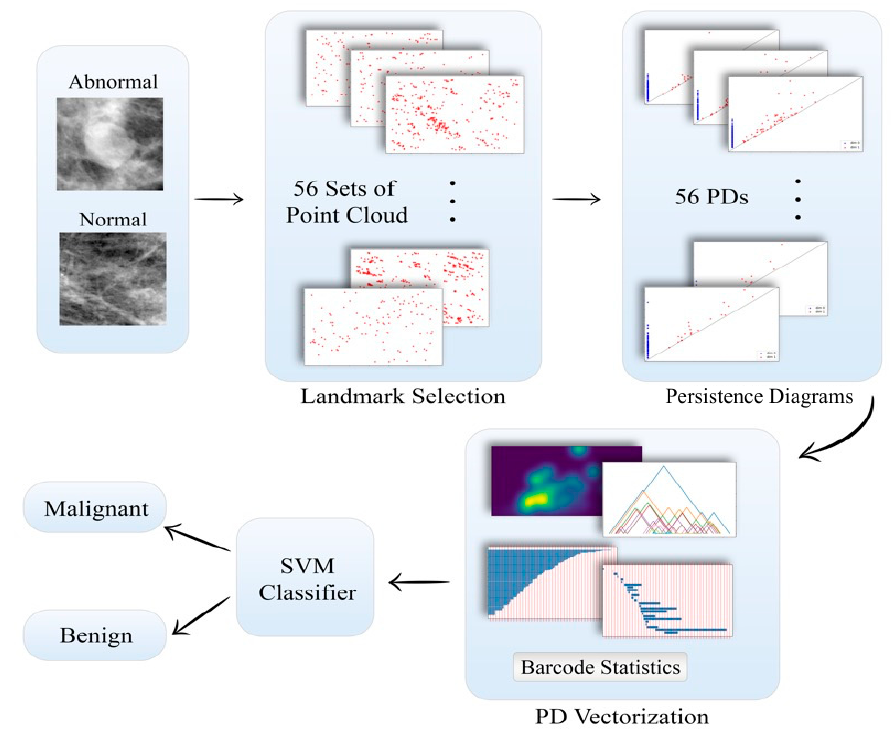
Figure 3. Landmark based PH construction and classification pipeline.